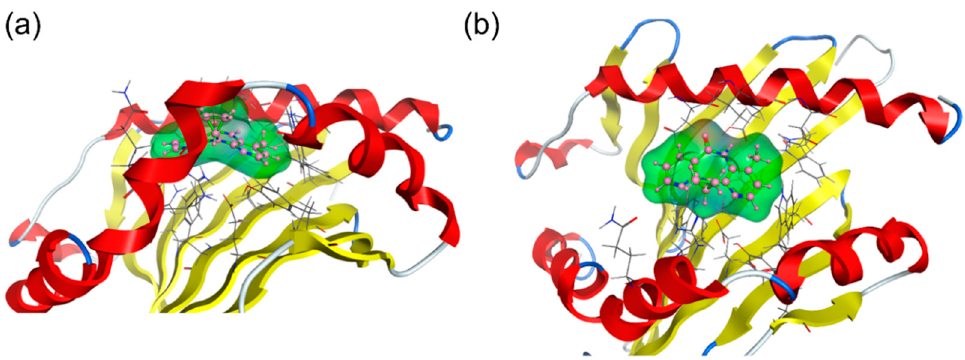
Figure 2. Binding mode of nevirapine to human leukocyte antigen (HLA)-DRB1*01:01 in docking simulations, ( a ) side view and ( b ) top view. The structures of HLA-DRB1*01:01, nevirapine, and amino acid residues of HLA-DRB1*01:01 in the vicinity of nevirapine are depicted in cartoon mode, ball-and-stick model, and wire model, respectively.